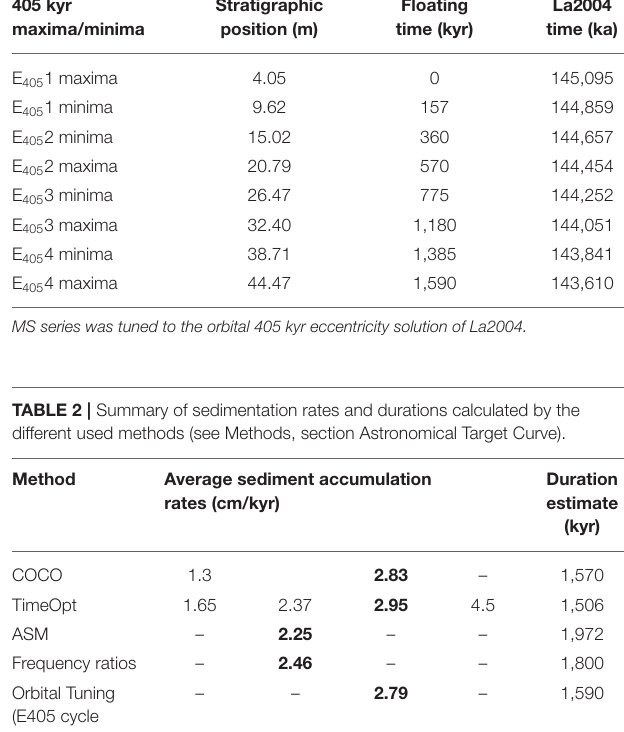
TABLE 1 | Stratigraphic positions, floating geochronology, and anchor points used to build the age model used in this study. 405 kyr maxima/minima